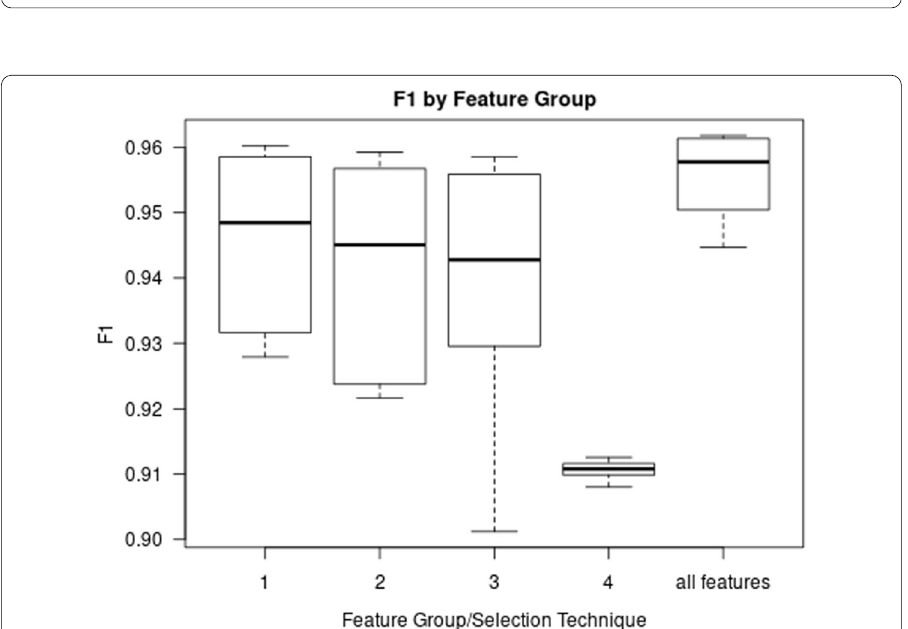
Fig. 8 Box plots of F1-score grouped by feature group/ selection technique; here datasets include destination port; Tukey’s HSD test indicates feature selection techniques 2 and 3 are not significantly different, other techniques are in groups by